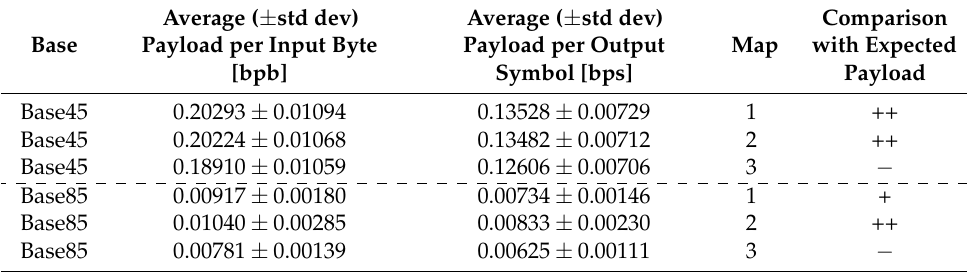
Table 6. Results of the Base45 and Base85 encodings applied to 109 compressed files (format .bz2).